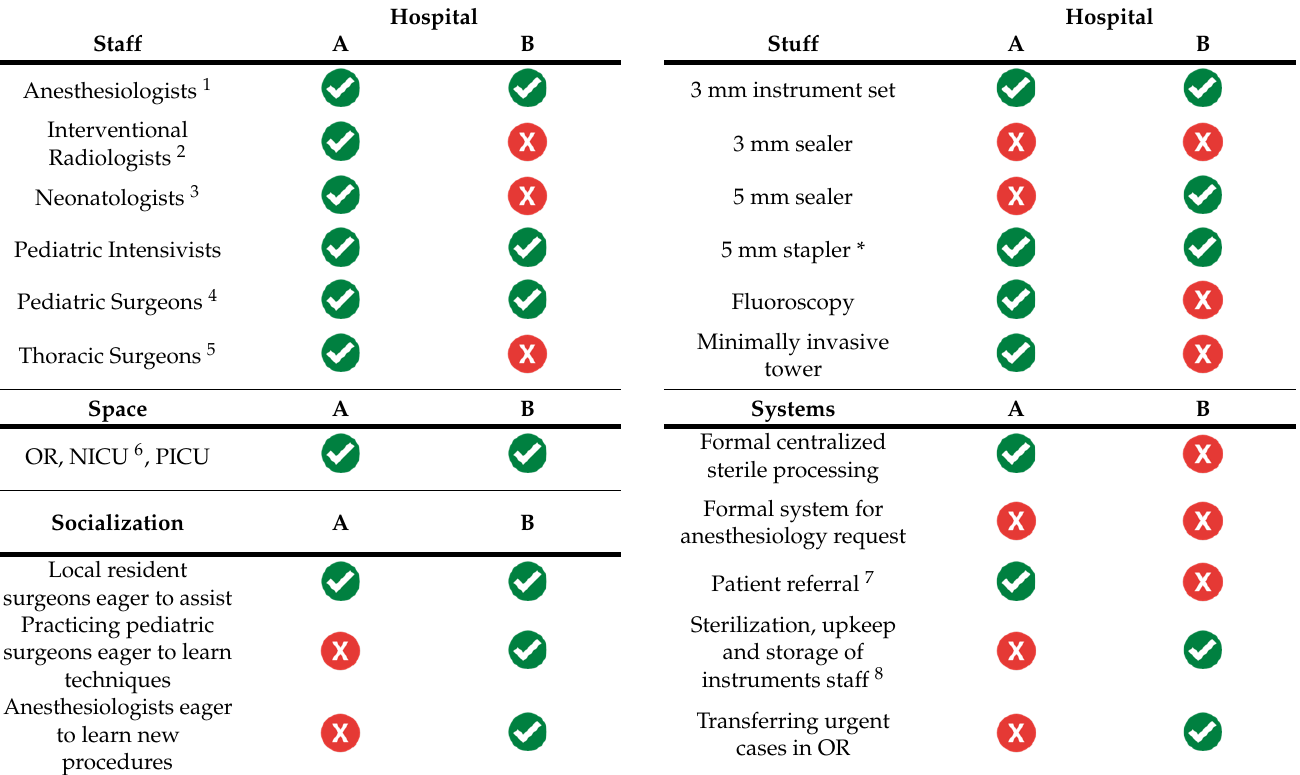
Table 3. The Five S Components.